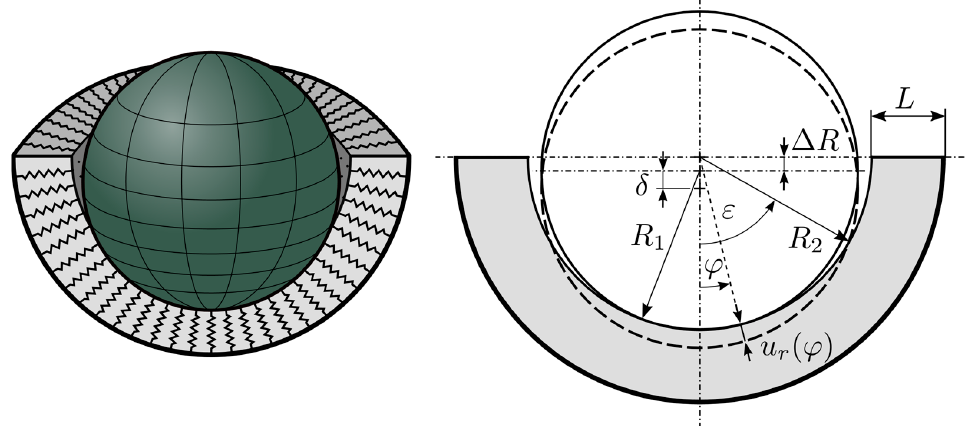
Figure 1. A rigid ball indenting a radial directed Winkler foundation of a spherical cup: Three-dimensional view ( left ), sectional view including kinematics of contact ( right ).